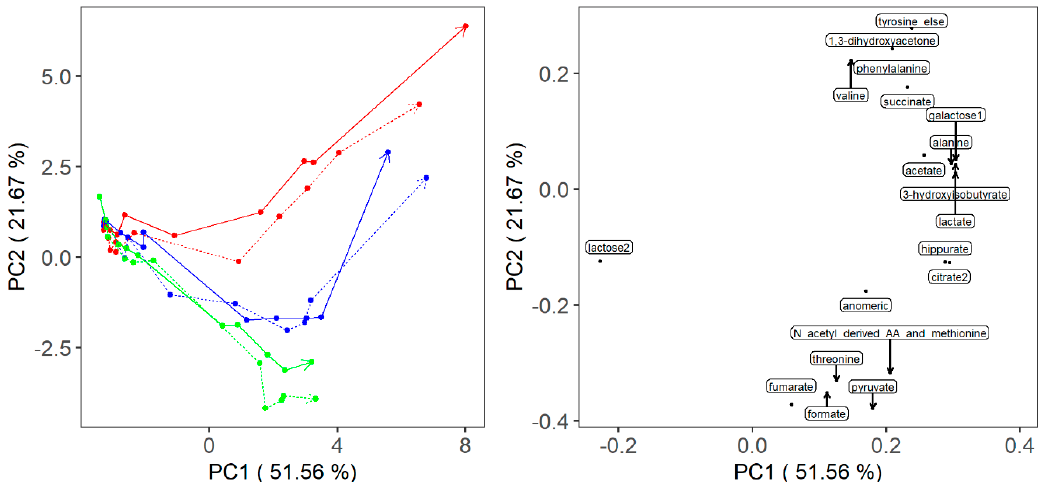
Figure A1. Principal component analysis of 19 signals from known metabolites. Left: score plot with fermentation time denoted by trajectories. Starter cultures are colored as follows: L. delbrueckii ssp. bulgaricus red, S. thermophilus green and their combination in blue. LT milk is represented with a full line, while HT milk with a dotted line. Right: loading plot.